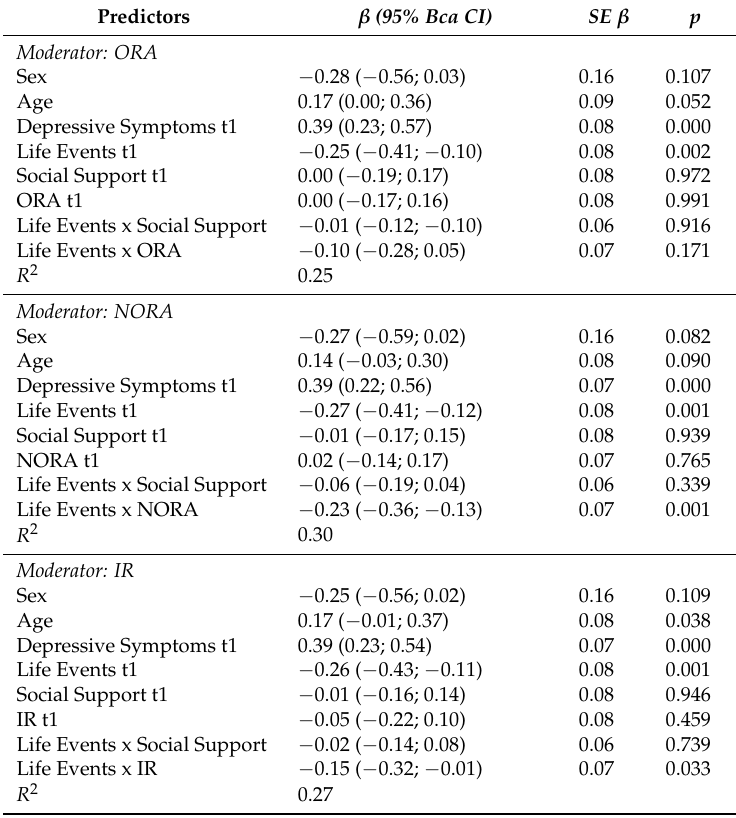
Table 3. Multiple linear regression for depressive symptoms at t2—divided by ORA, NORA, IR ( n =